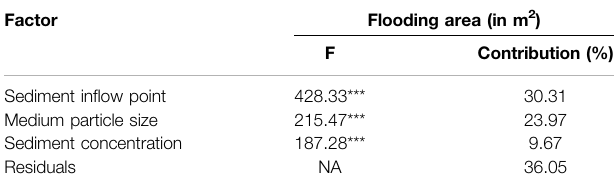
TABLE 4 | Results of two-way ANOVA test on the effects of sediment characteristics (in fl ow, medium particle size, and concentration) on the fl ooding area. Asterisk indicates signi fi cant correlations ( p < 0.001). NA: not